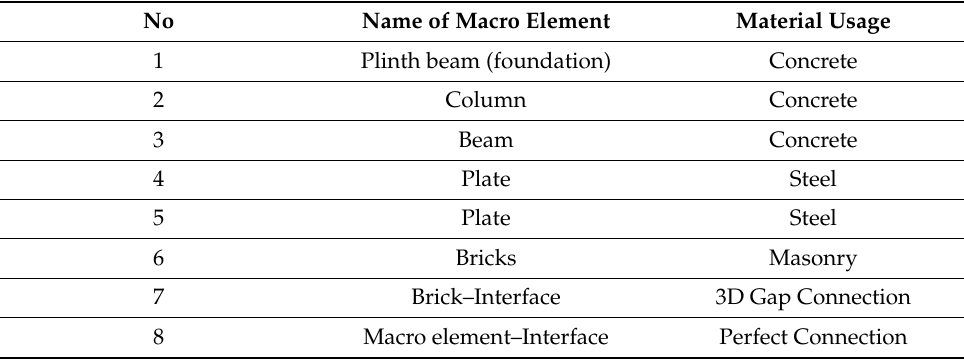
Table 3. Meshing configuration of meso modeling.